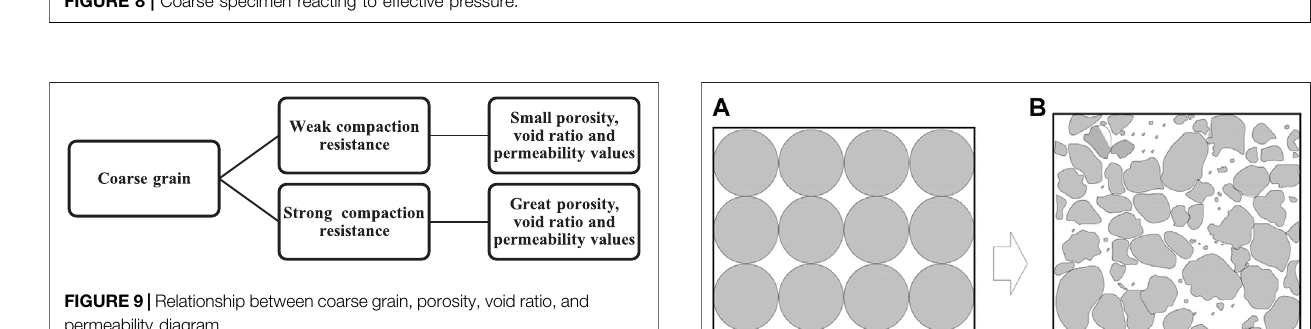
FIGURE 8 | Coarse specimen reacting to effective pressure.